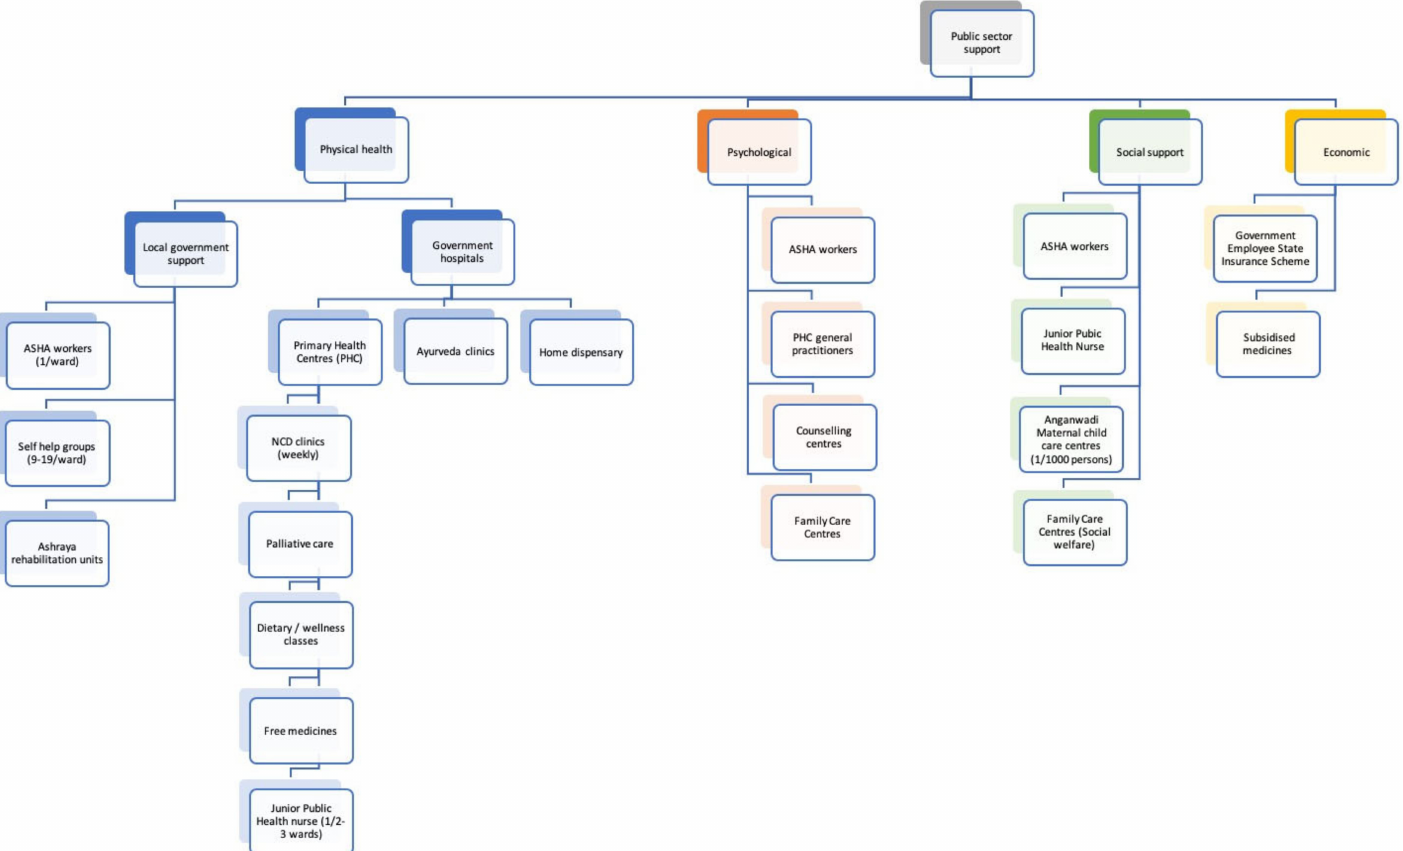
Figure A1. Mapping Public Sector Support Services in One District in